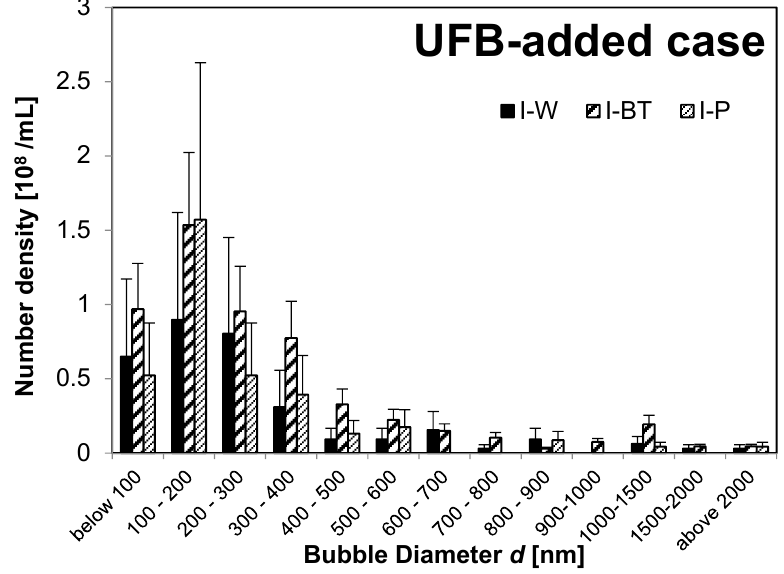
Figure 2. Number of fine bubbles of UFB-added case: I-W (solid black), I-BT (thick oblique line), and I-P (thin oblique line).